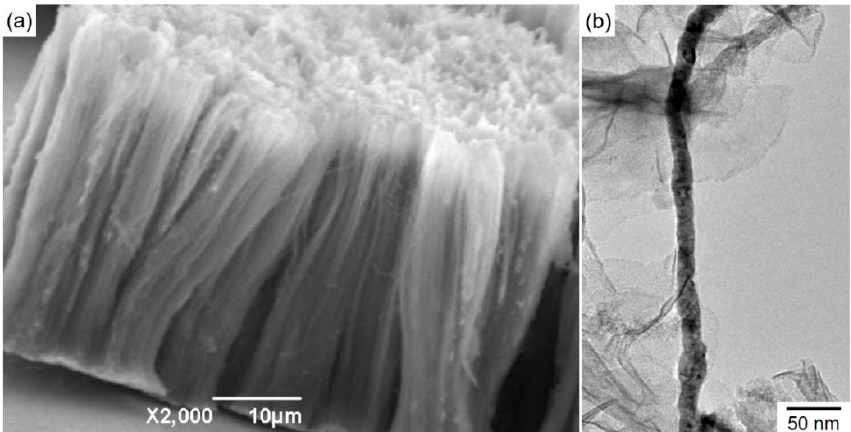
Figure 7. SEM image ( a ) and transmission electron microscope (TEM) bright field image ( b ) of electrodeposited Co nanowires electrodeposited potentio-statically. Co nanowires were separated from an anodized aluminum oxide nanochannel template.